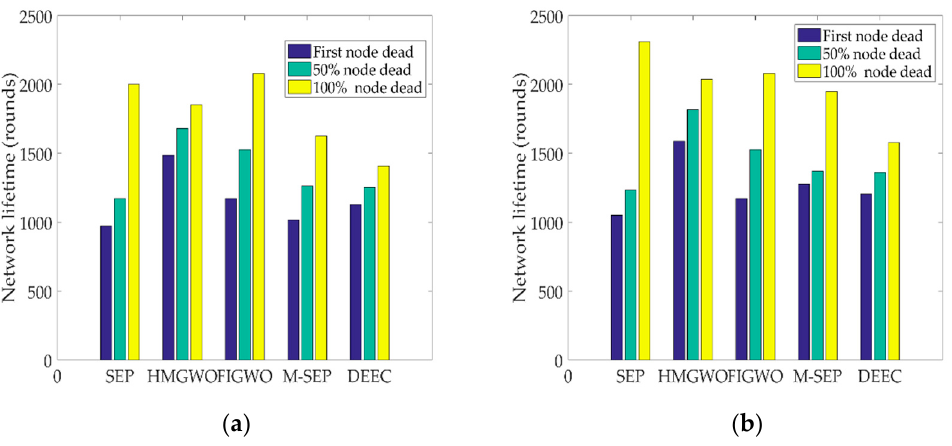
Figure 2. Network stability period with respect to the number of rounds. ( a ) The ratio of the advanced node is 0.1, and the HMGWO network stability period is compared with SEP, DEEC, M-SEP, and FIGWO; ( b ) The ratio of the advanced node is 0.2, and the network stability period of HMGWO relative to SEP, DEEC, M-SEP, and FIGWO.